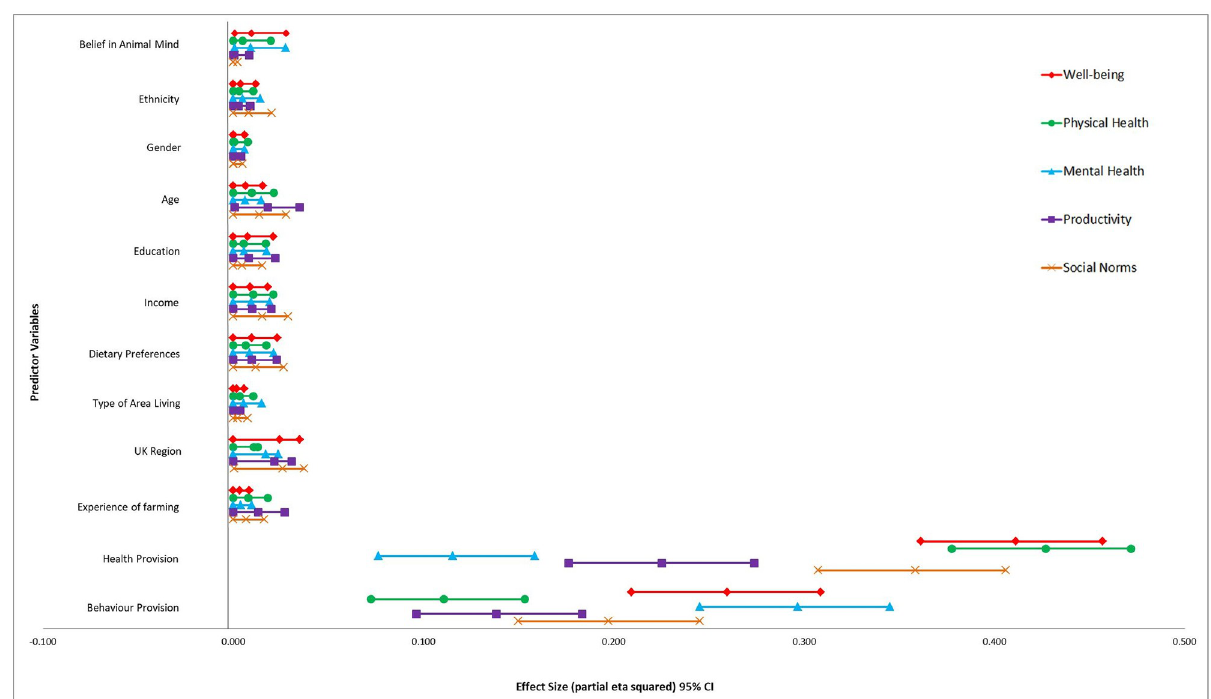
Fig 2. Impact of participant characteristics and vignette conditions on judgements of well-being, physical health, mental health, productivity and social norms.